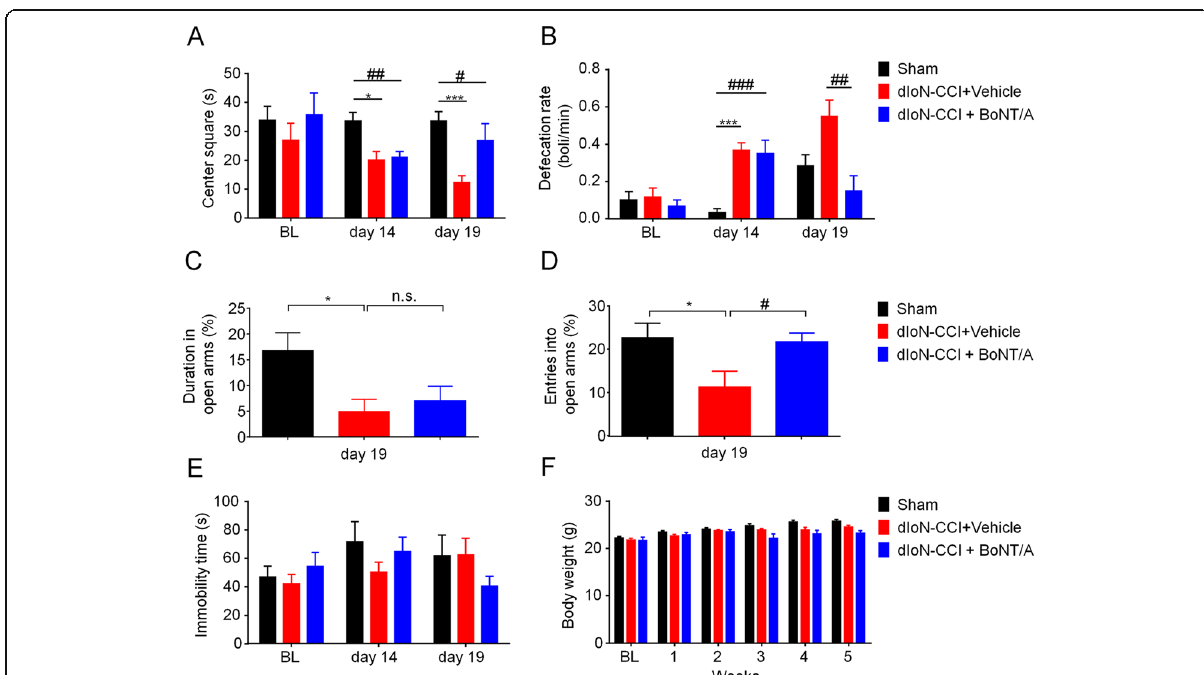
Fig. 3 Facial injection of BoNT/A attenuated dIoN-CCI surgery-induced anxiety-like behavior, but not depression-like behavior, in mice. On day 14 following dIoN-CCI surgery, BoNT/A was injected in dIoN-CCI mice. a In open field test, on day 5 after BoNT/A injection (day 19 following dIoN- CCI surgery), BoNT/A treatment significantly increase the time in the center area compared with that of vehicle group. b On day 5 after BoNT/A injection (day 19 following dIoN-CCI surgery), BoNT/A treatment significantly decrease the excretion rate compared with that of vehicle group. c - d In an elevated plus maze, on day 5 after BoNT/A injection (day 19 following dIoN-CCI surgery), BoNT/A treatment had no significant effect on the percentage of duration of open arms compared with that of vehicle group ( c ). BoNT/A treatment significantly increased the percentage of entries into the open arm in an elevated plus maze than that of vehicle group ( d ). e - f There was no significant change in the duration of the immobility time in FST test ( e ), the body weight ( f ) among the three groups during the experiment. Data was expressed as Mean ± SEM. ( n = 8 each group, n.s., no significance, * P < 0.05, *** P < 0.001 compared with the sham group. # P < 0.05, ## P < 0.01, ### P < 0.001 compared with the dIoN-CCI group, unpaired Student ’ s t-test). dIoN-CCI, chronic constriction injury of distal infraorbital nerve; BoNT/A, botulinum toxin A;